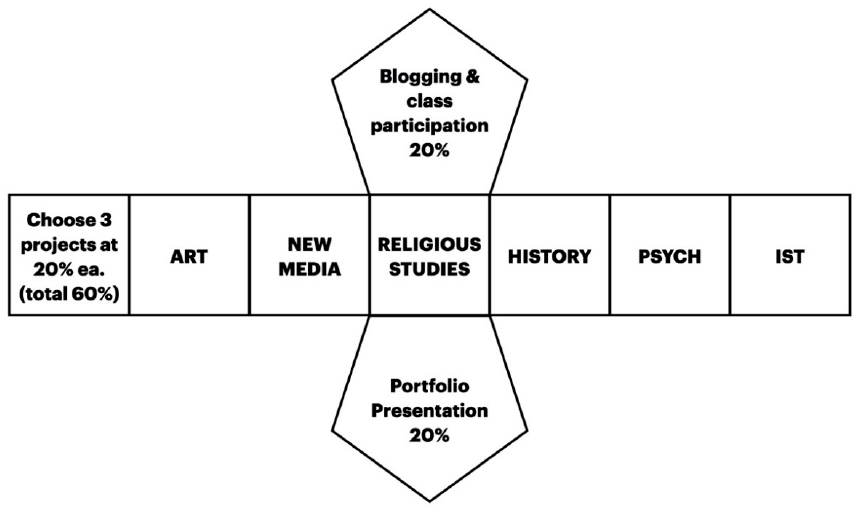
Figure 1. Image representing the components of the final grade, from the syllabus for LA 497. Religions 2020 , 11 , x FOR PEER REVIEW